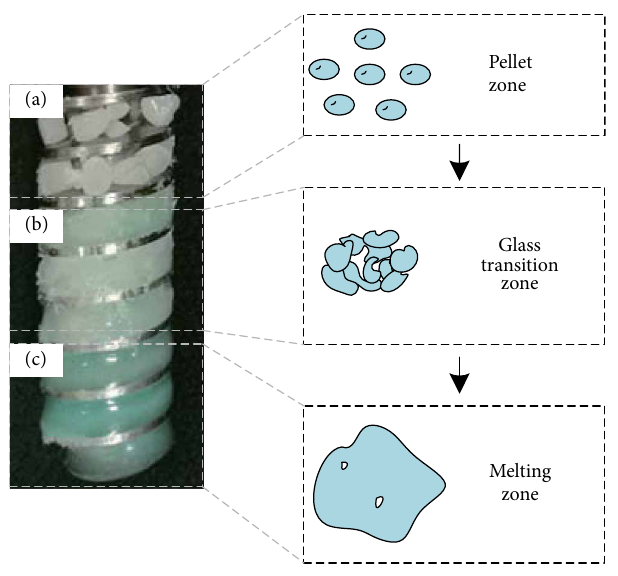
Figure 2: The experiencing zones of pellets: (a) pellet zone; (b) glass transition zone; (c) melting zone.